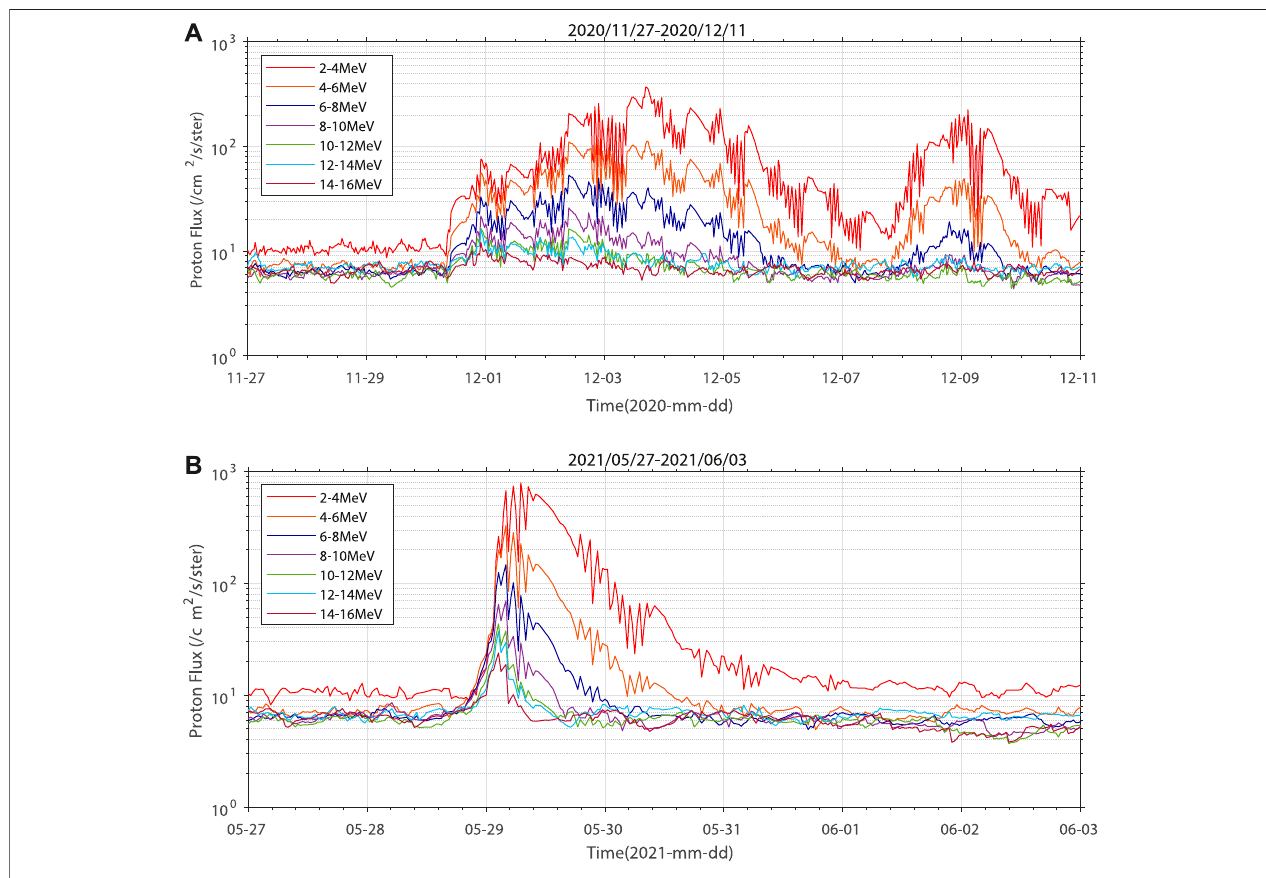
FIGURE7| Theevolutionoftheproton fl uxesatdifferentenergiescorrespondingto L =5~9 (A) forthegradualSPEof2020and (B) fortheimpulsiveSPEof2021.